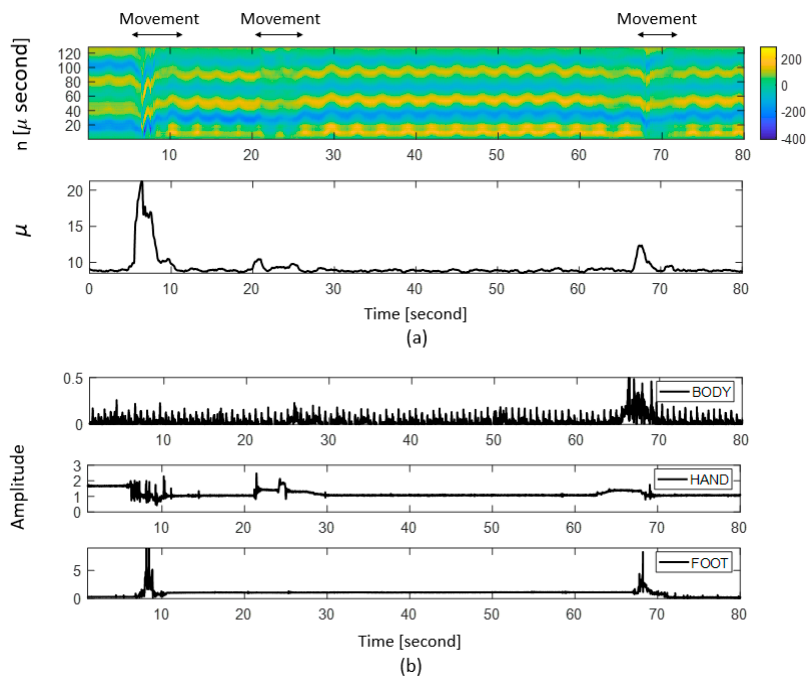
Figure 2. Comparison of the quantification accuracy of motion index. ( a ) Respiratory signal and motion quantification index, ( b ) acceleration value for different parts of the driver’s body (chest, back of the hand, and back of the foot) .